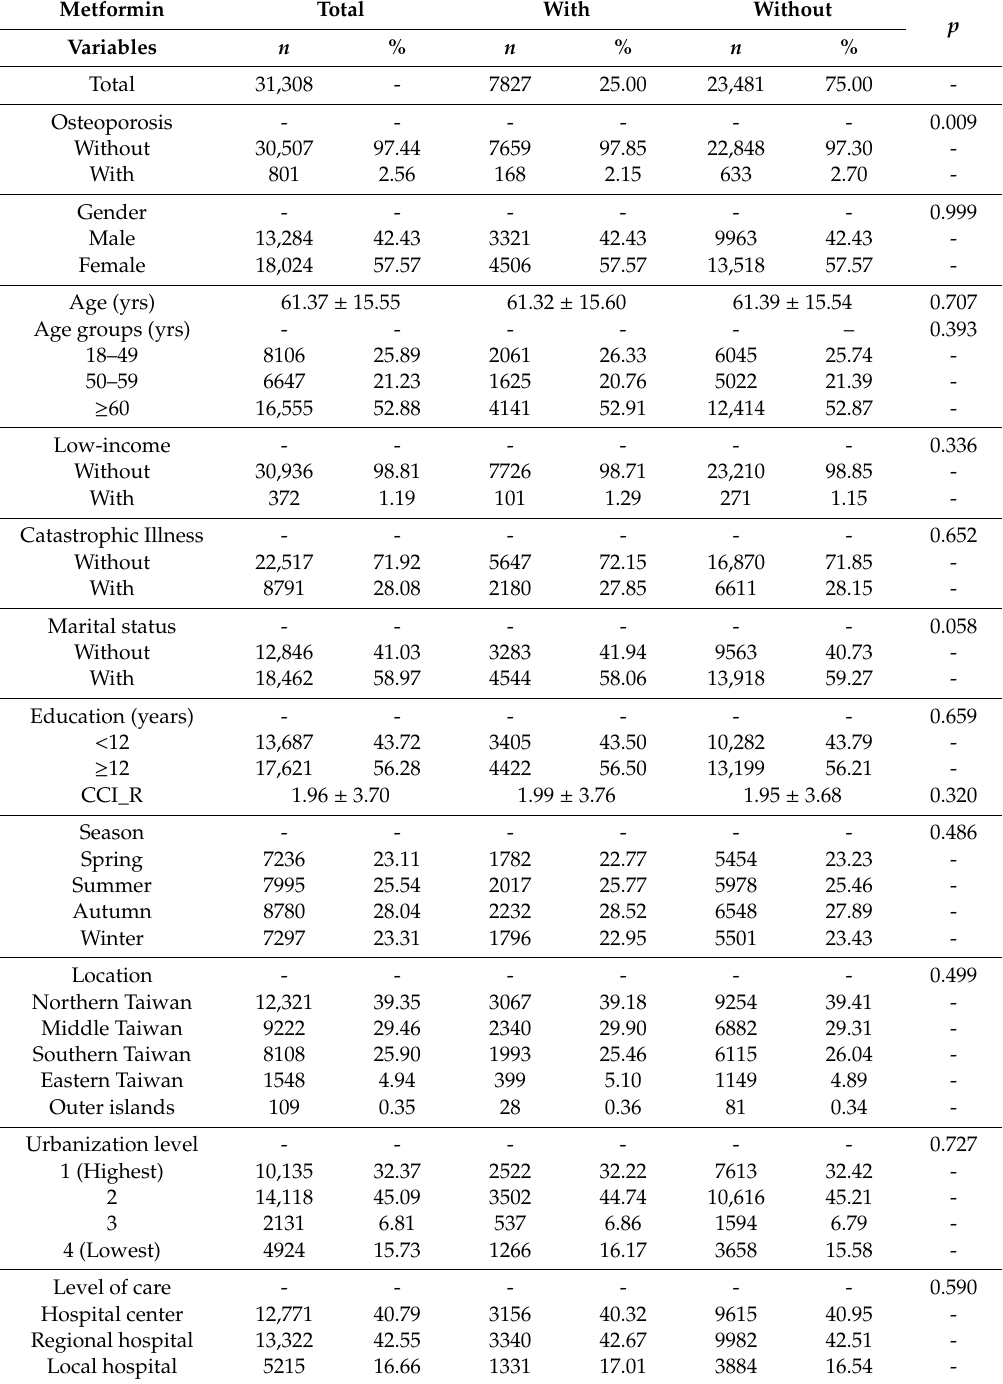
Table 2. Characteristics of study in the